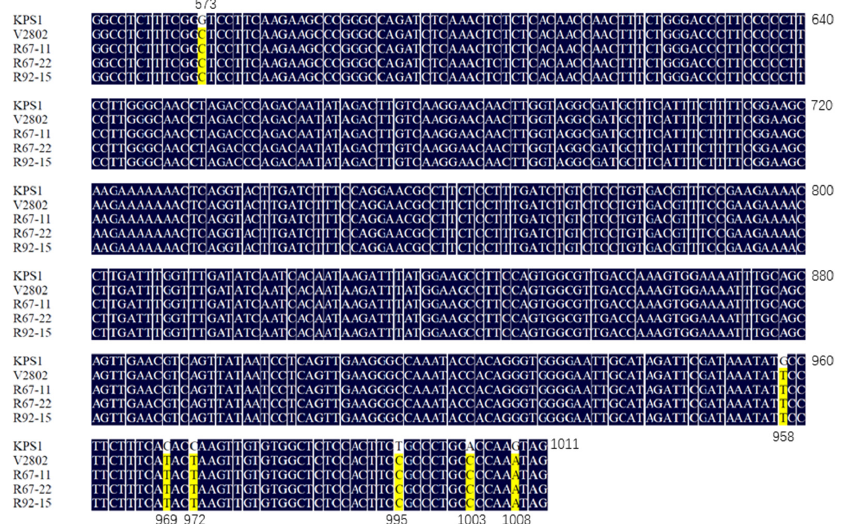
Figure 2. Alignment of the coding sequence of VrPGIP2 from KPS1, V2802, R67-11, R67-22, and R92-15 (portion containing differential bases). The numbers labeled under the bases indicate the location of SNPs from the start codon.